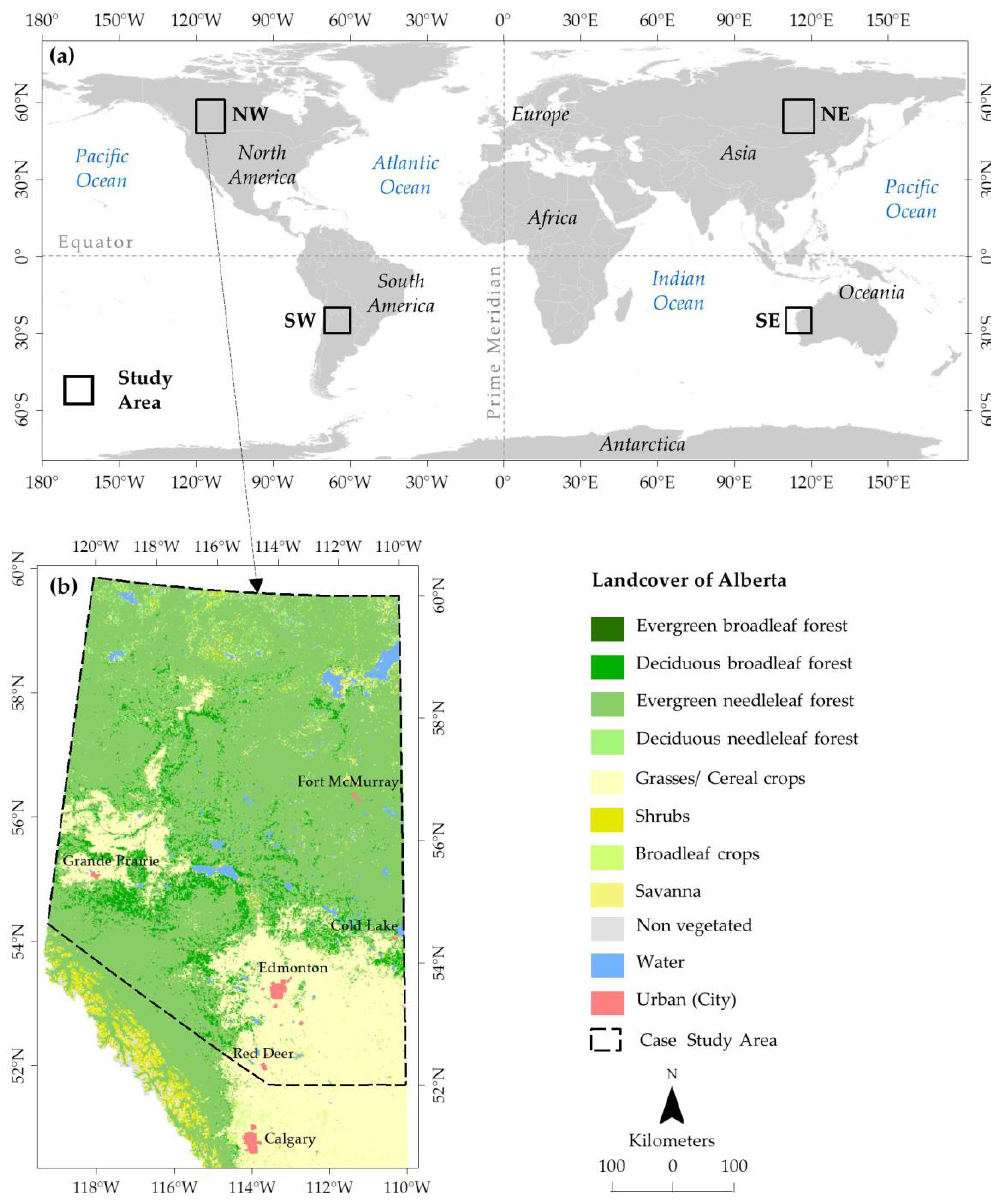
Figure 2. Study areas in the four AOIs located in the NW, NE, SE, and SW hemispheres in the globe ( a ); and processed Ts swath data were used in the forest landcover of Alberta located at the NW AOI to forecast forest fire danger conditions ( b ).